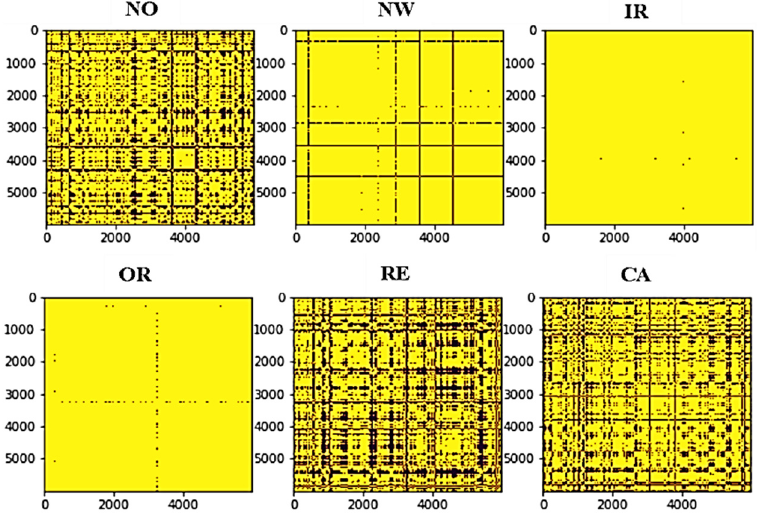
Figure 11. Examples of the generated vibration image using the RP technique with a distance threshold for bearing vibration with six health conditions.